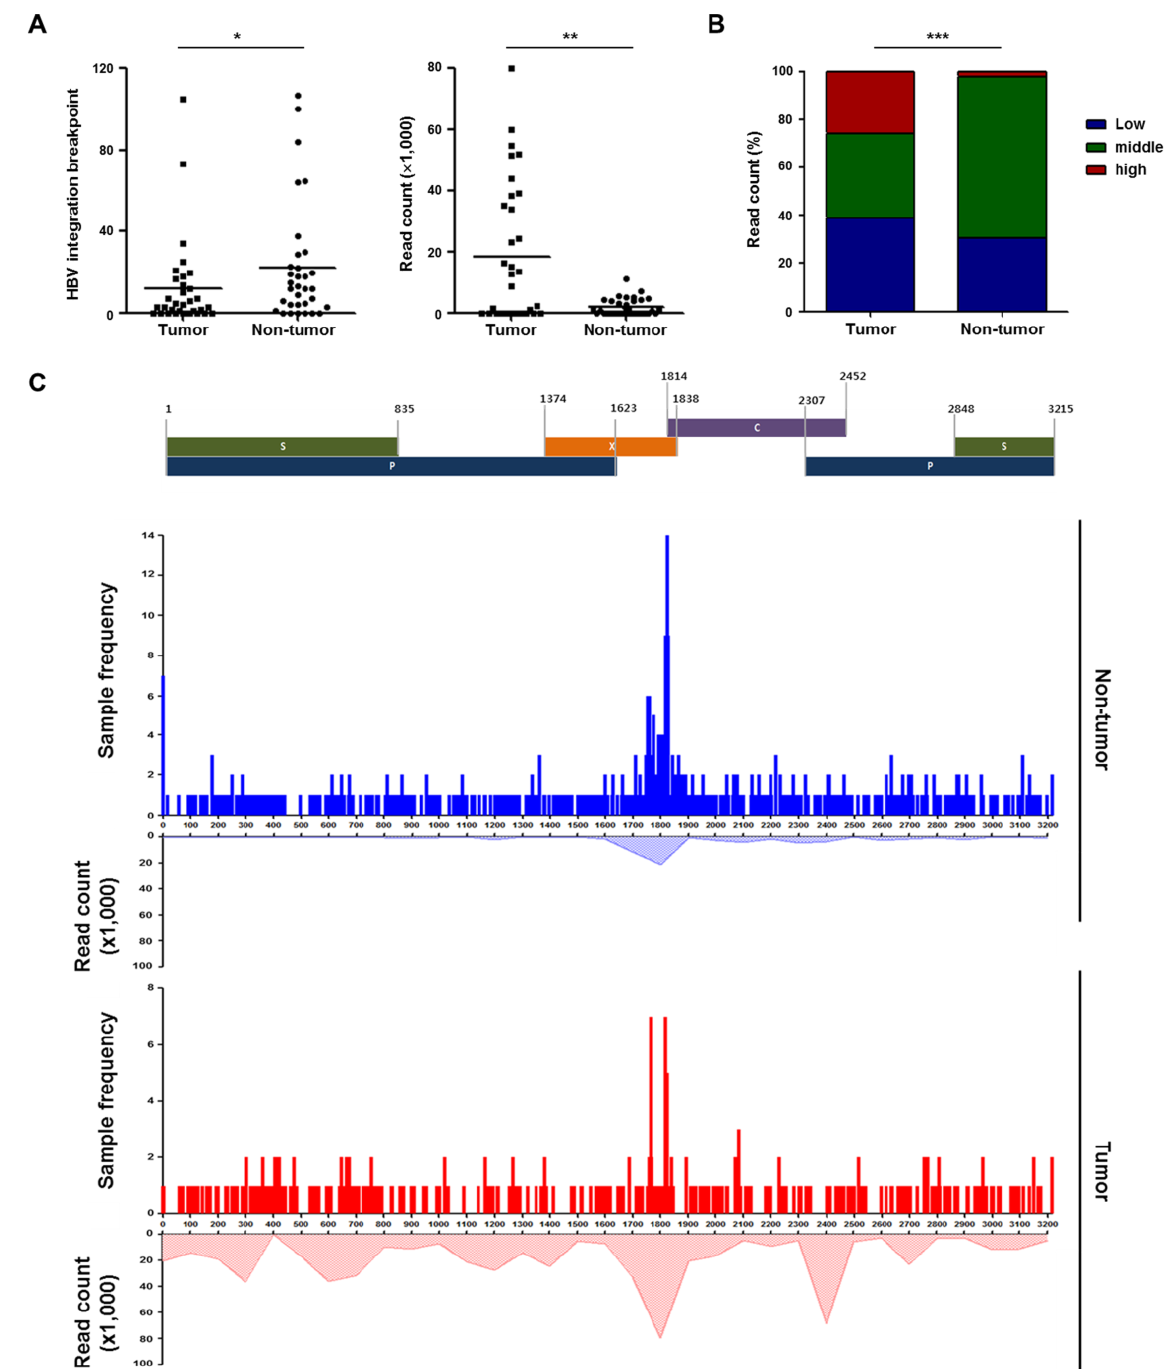
Figure 2. Comparison of HBV integrations between paired tumor and non-tumor tissues. ( A ) HBV breakpoints and read counts. ( B ) Proportion of tissues with low, middle, and high read counts. ( C ) Location, frequency, and read counts of HBV breakpoints in the HBV genome of tumors and non-tumor tissues. p -value (binomial distribution): * < 0.05, ** < 0.01, *** < 0.001